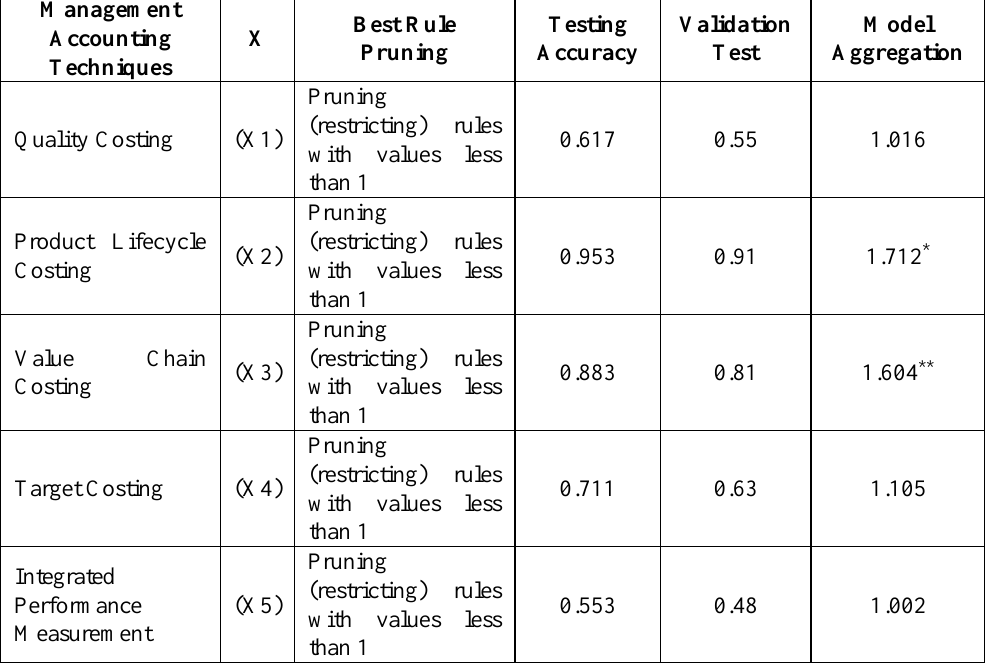
Table 9. Cross-validation test results to evaluate management accounting